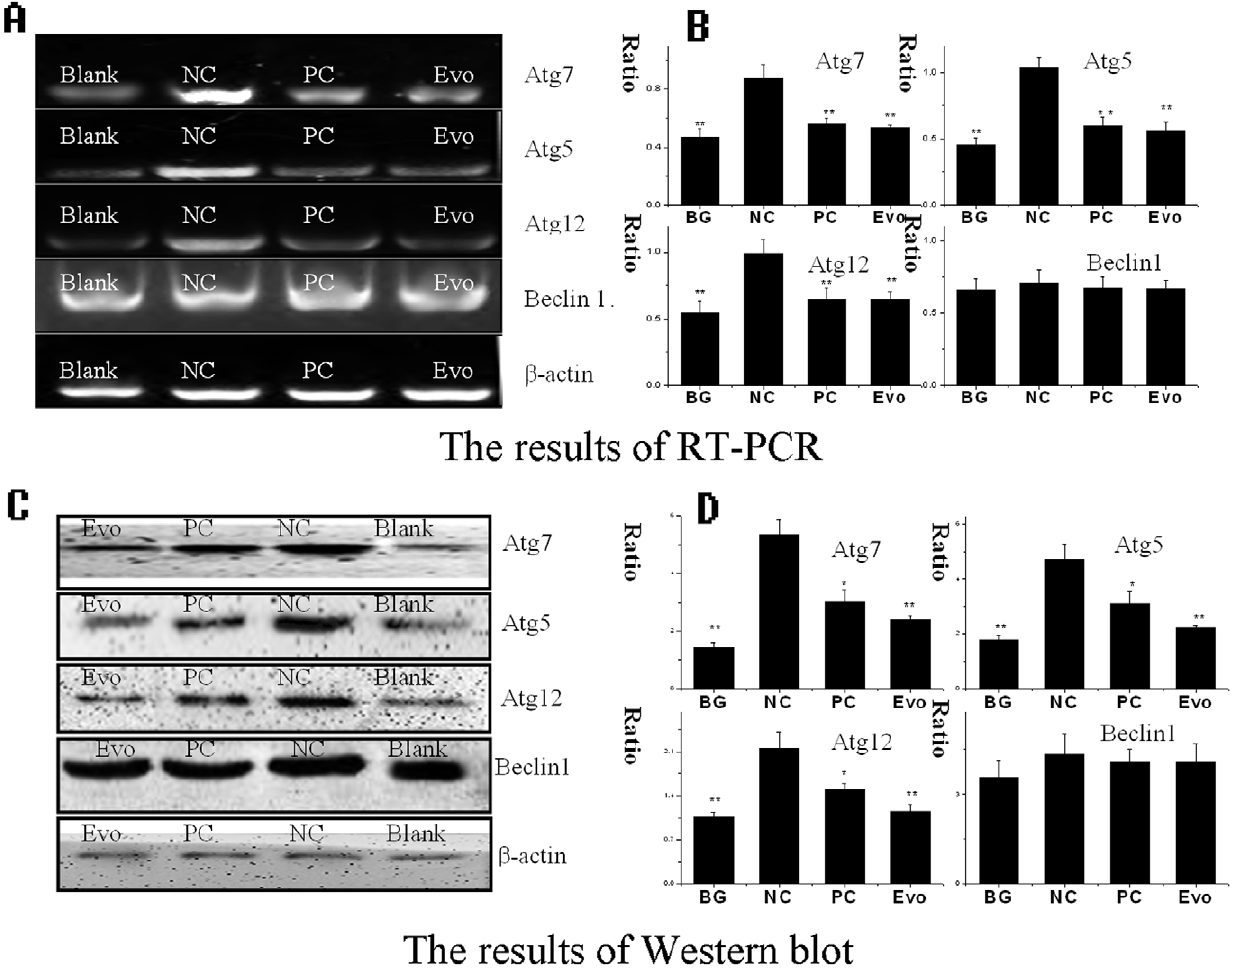
Figure 7. Evodiamine inhibits the expression of autophagy-related genes. ( A , B ) The results of the RT-PCR assay. ( C , D ) The results of the Western blot assay. In the BG group, the A549 cells were not infected with IAV and not treated with any drugs; In the NC group, the A549 cells were infected with IAV but not treated with drugs; In the PC and Evo groups, the A549 cells were infected with IAV and treated with ribavirin (25 m g/mL) and evodiamine (12.5 m g/mL), respectively. MOI=0.001, incubation time=24 h. The total gray value of each band was determined using a Gel-Pro analyzer 6.0. The data shown were the ratios of the expression of the target gene to b -action. Data shown were the mean 6 SD of three independent experiments. * P , 0.05, ** P , 0.01, vs . the NC.